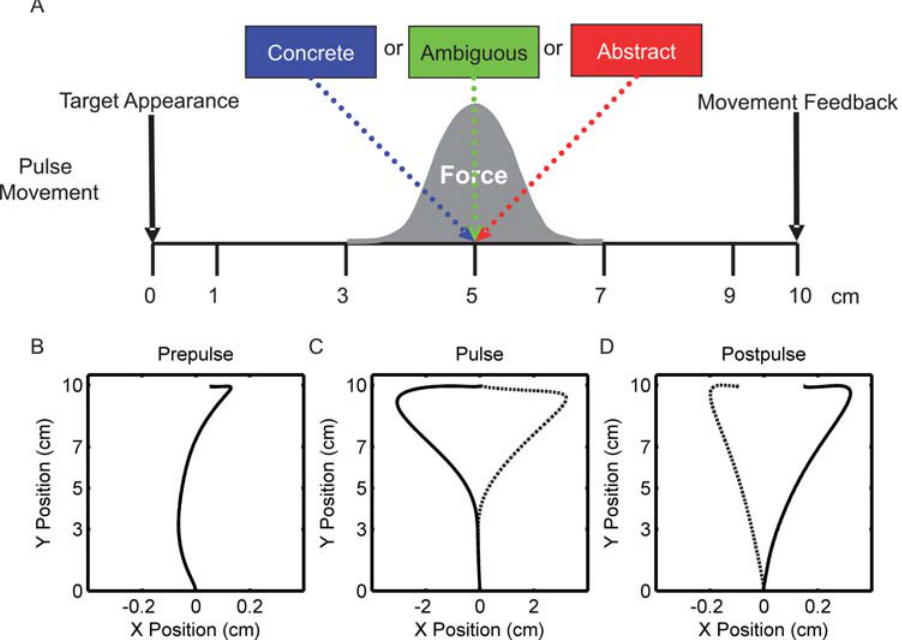
Figure 1. The experimental setup and the averaged movement trajectories for prepulse, pulse and postpulse movements. A) Dual- task setup during pulsed movements. Hand position in the y-direction (toward the target) triggered perturbation force in the x-direction and/or the onset of the word presentation. The force perturbation was centered at y=5 cm. When the hand arrived at y=5 cm, either a concrete (blue), abstract (red), or ambiguous (green) word was presented. The word was 500 ms in duration. At the end of movement, subjects received feedback on the correctness of the movement, but no feedback on the categorization was provided. B) Average, across all dual-task conditions, prepulse movement trajectory. C) Average pulse movement trajectories for leftward (solid) and rightward (dashed) force perturbations. D) Average postpulse movement trajectories, minus the average prepulse movement trajectory, following leftward (solid) and rightward (dashed) force perturbation.